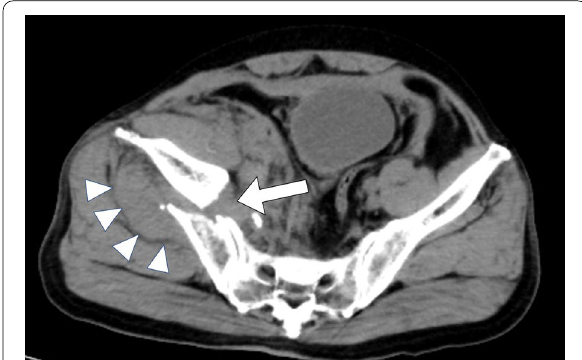
Fig. 1 CT findings on day 1. CT revealed a right pelvic fracture (arrow) and a haematoma (arrowhead) in the pelvic extraperitoneal